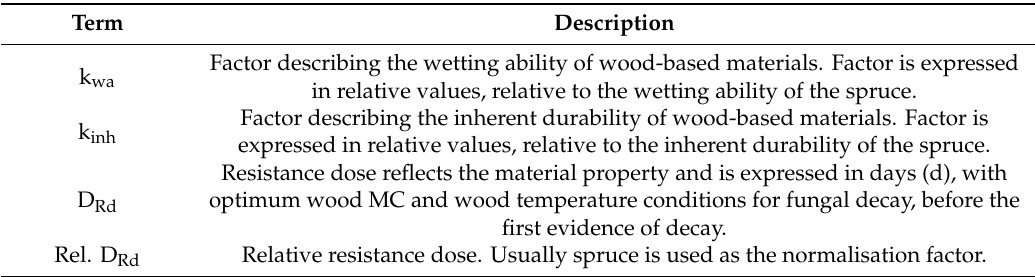
Table 2. Description of key terms addressed in respective